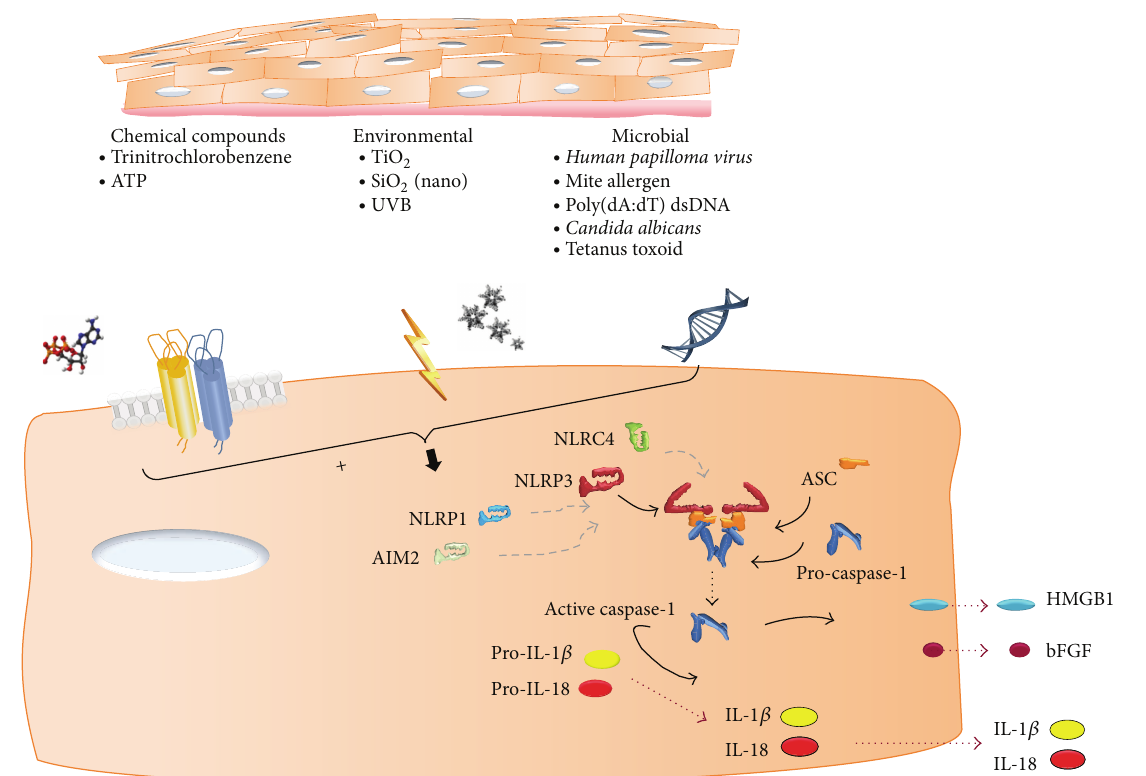
Figure 2: Schematic representation of stratified squamous epithelium of the skin and oral mucosa. Toxic molecules and environmental and cellular stressors as well as microbial antigens can individually activate one or more inflammasome subtypes, leading to caspase-1 activation and the release of IL-1 𝛽 , IL-18, bFGF, and